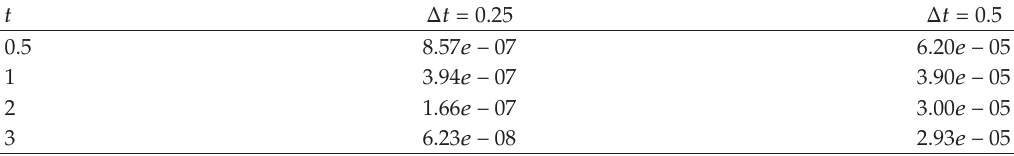
Table 1: RMS errors for Problem 1 with N (cid:6) 11 using Dirichlet boundary conditions.